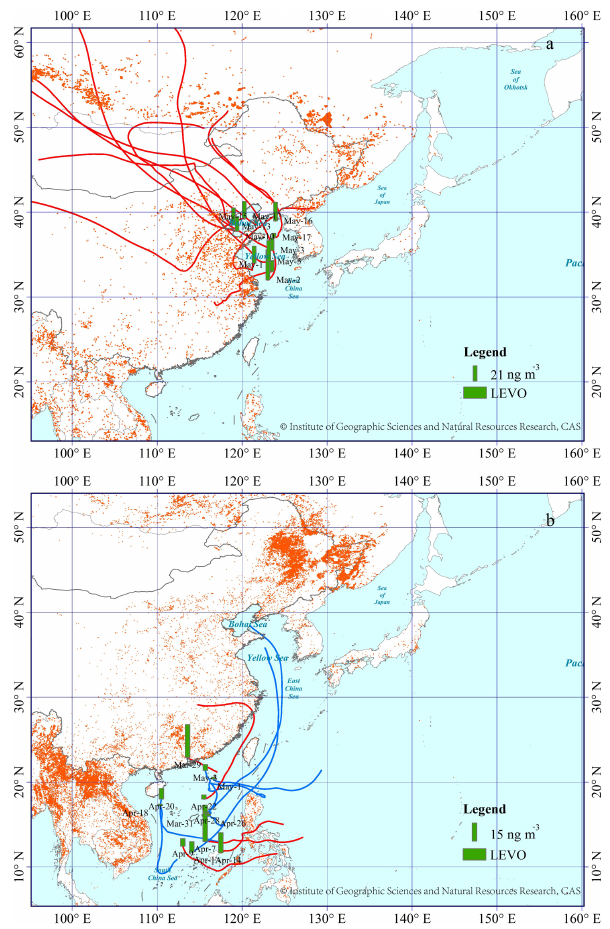
Figure 2. (a) The spatial distribution of LEVO over the YBS (2014), and (b) SCS (2017); detailed information is given in Fig. 1. The base map was sourced from the Resource and Environment Data Cloud Platform (http://www.resdc.cn/DOI/doi.aspx?DOIid=56), © Insti- tute of Geographic Sciences and Natural Resources Research, Chi- nese Academy of Sciences (CAS). (Please note that the above figure contains disputed